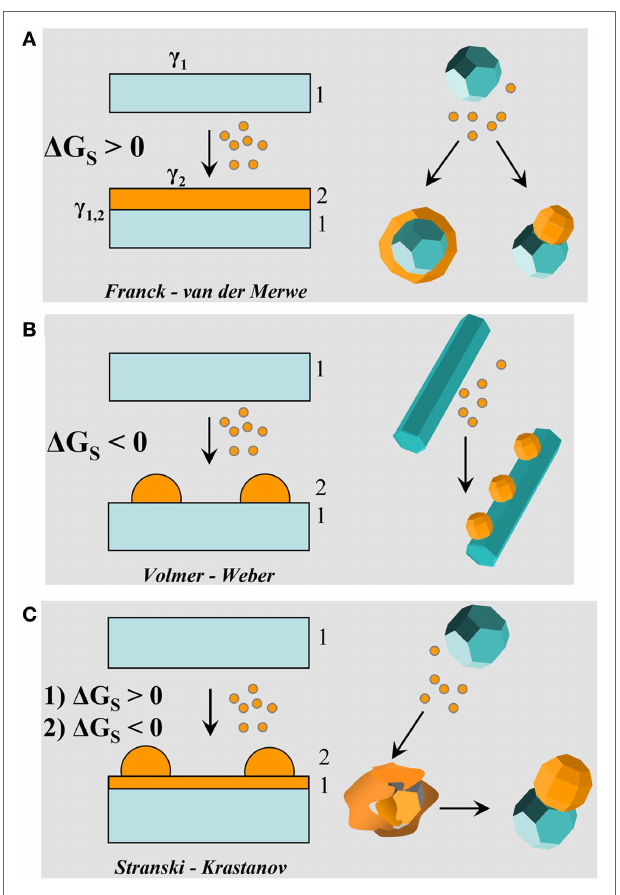
FIGURE 1 | Comparative sketches illustrating possible heterogeneous deposition modes for a secondary material (referred to as “2”) that is deposited from the respective molecular precursors onto a preformed seed substrate of a different material (referred to as “1”) . ( A ) Franck– van der Merwe ; ( B ) Volmer–Weber ; and ( C ) Stranski–Krastanov regimes [adapted from Casavola et al. (2008) with permission, copyright Wiley-VCH Verlag GmbH & Co.